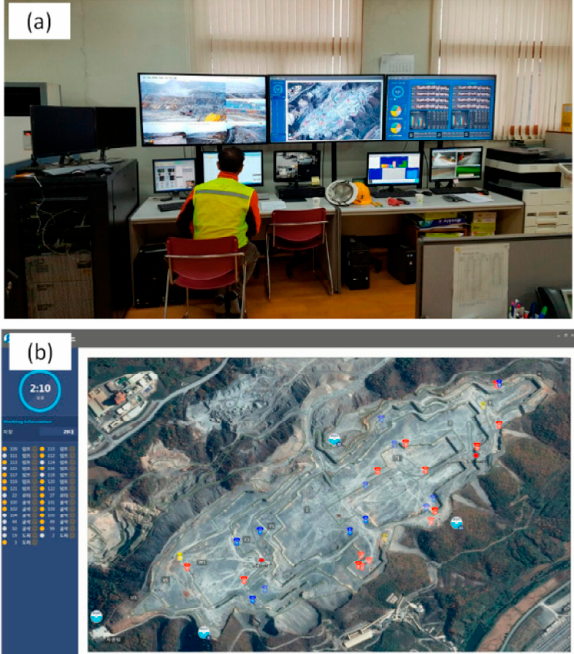
Figure 10. An open-pit mine in South Korea with a wireless communications system for fleet management of mine equipment. ( a ) Control center. ( b ) Main dashboard (Reprinted from Ref. [65]).